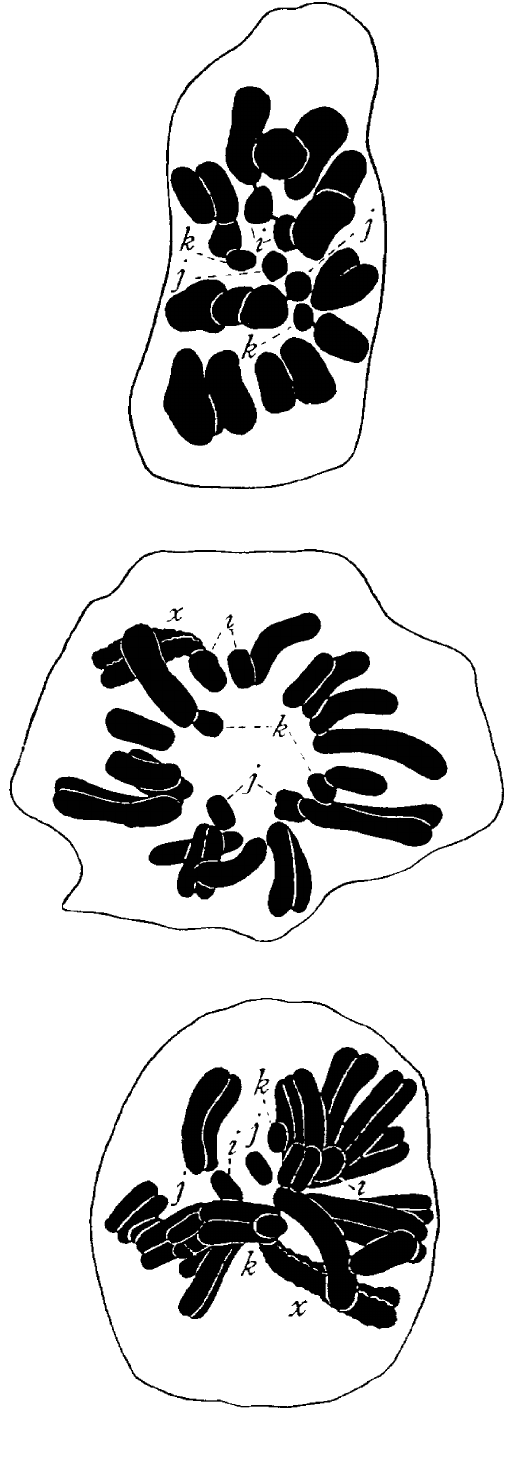
Figure 3 - Sutton’s drawings of Brachystola magna chromosomes during nuclear division, showing the three smallest chromosome pairs (i, j, k) and the accessory chromosome (x) (Sutton, 1902, figs. 1, 2,